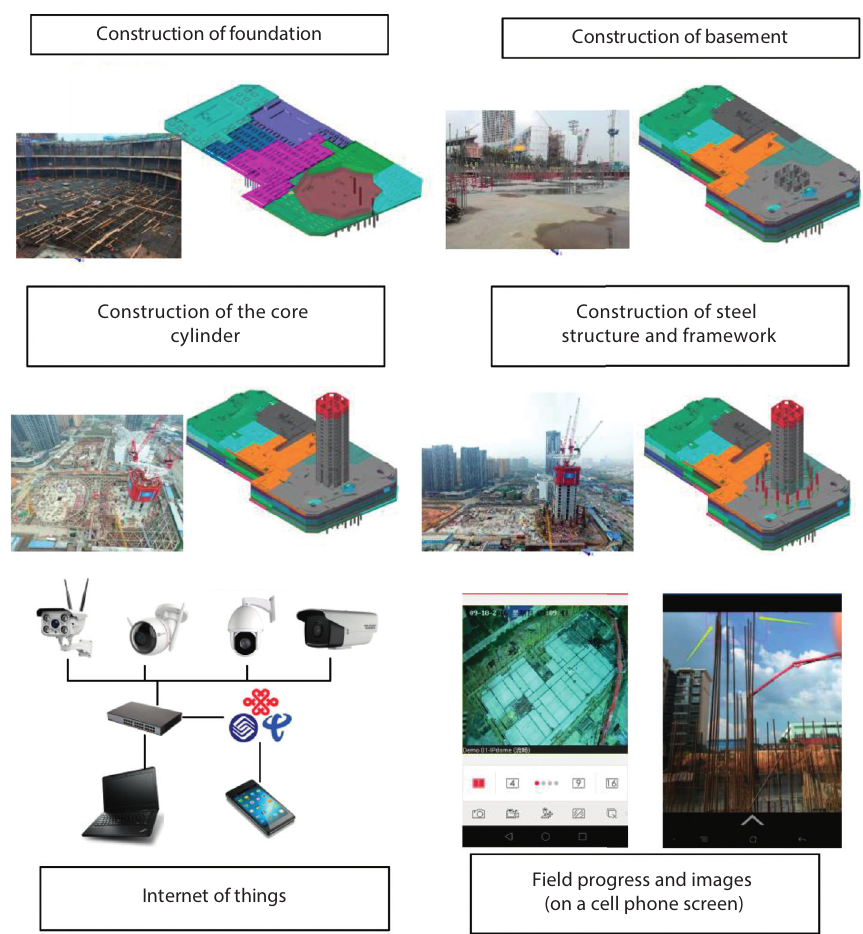
Figure 15: The modeling progress, capital plan, and field progress of the project in BIM platform.